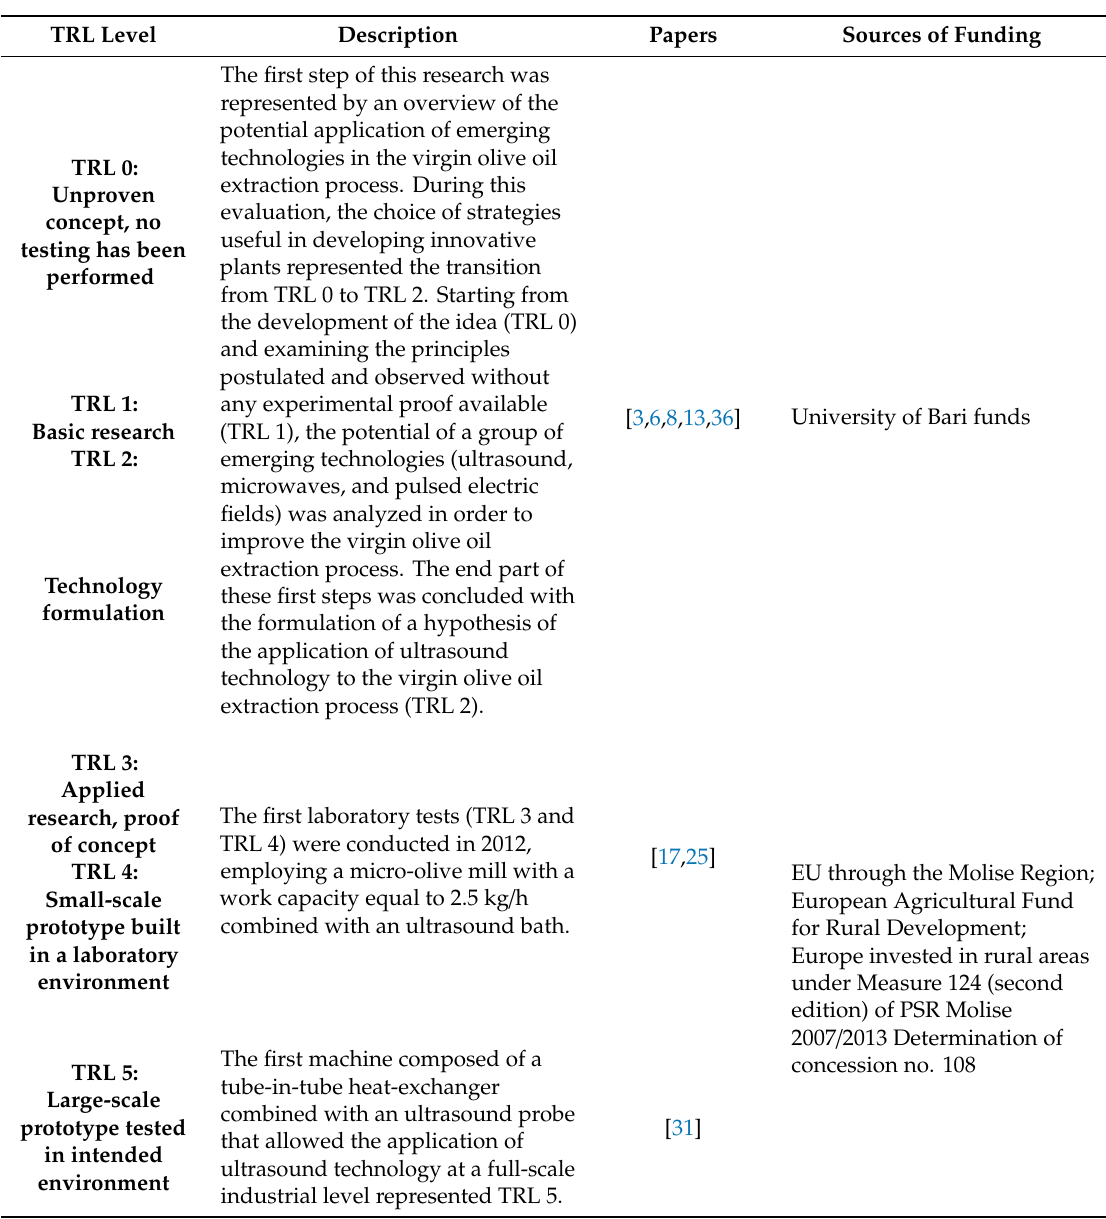
Table 3. Mix of skills needed for a rapid TRL ascent: Multidisciplinary skills of the research team, ability to attract funding, and dissemination of